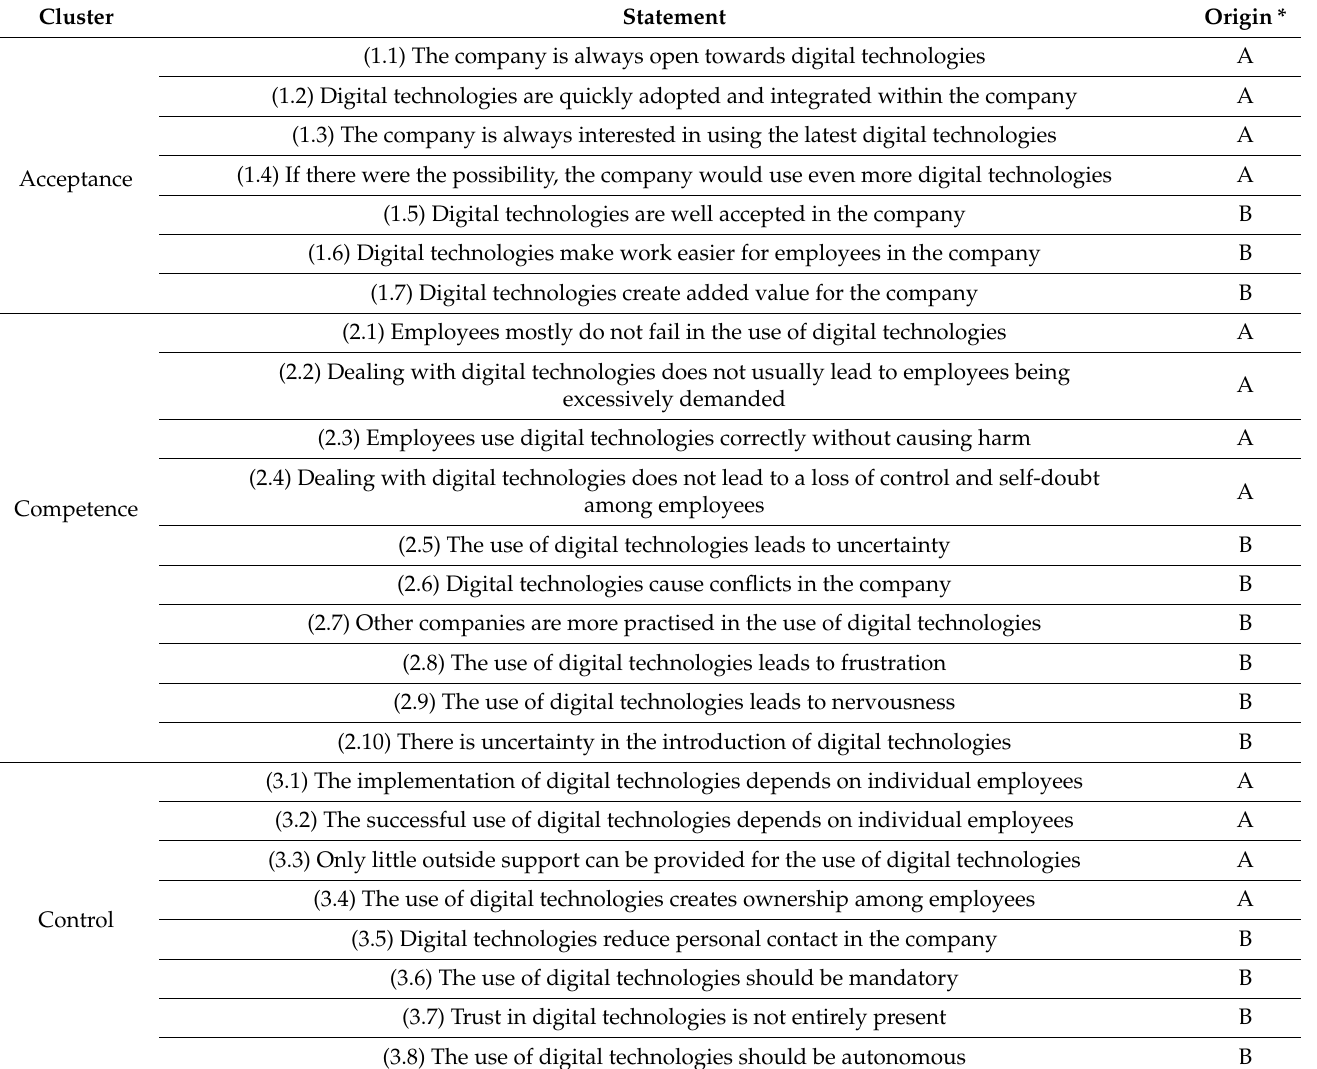
Table 3. Statements of the new survey